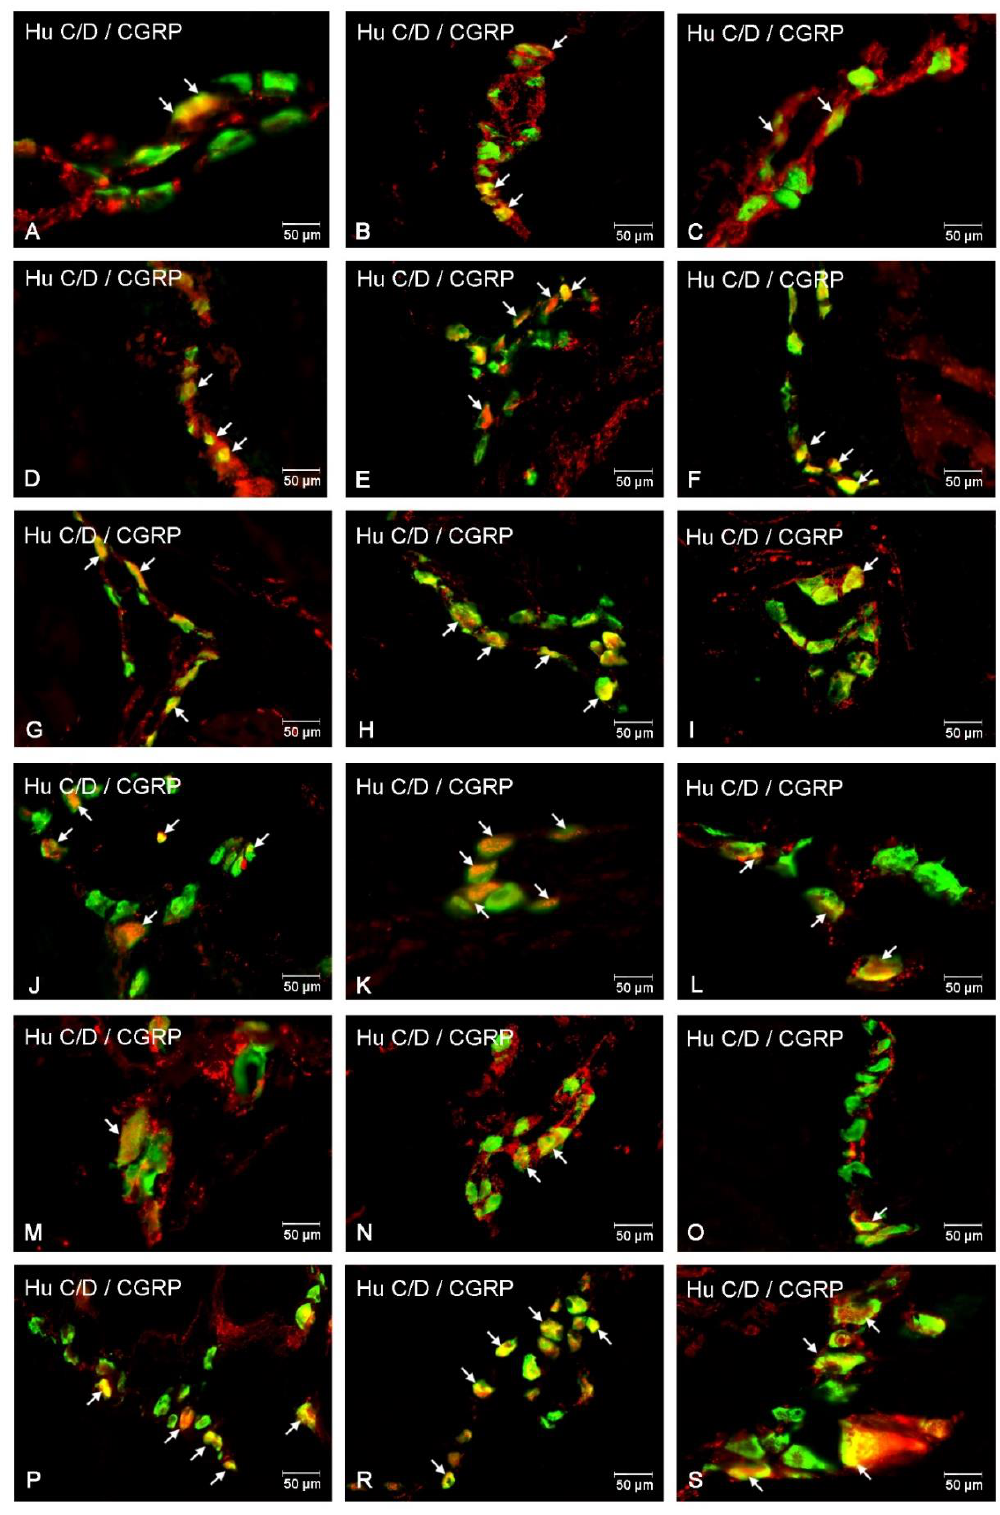
Figure 8. Immunofluorescent staining presenting CGRP immunoreactivity in cell bodies in the particular intramural plexuses in the small intestine in both control and experimental groups. All photographs have been created by the digital superimposition of two color channels; Hu C / D-positive—used here as a pan-neuronal marker (green), and CGRP-positive (red). The arrow shows perikaryon containing both examined substances. Myenteric plexus of the duodenum ( A,D ), jejunum ( B,E ), and ileum ( C,F ) under physiological condition ( A–C ) and after streptozotocin administration ( D–F ). Outer submucosal plexus of the duodenum ( G,J ), jejunum ( H,K ), and ileum ( I,L ) under physiological condition ( G-I ) and after streptozotocin administration ( J–L ). Inner submucosal plexus of the duodenum ( M,P ), jejunum ( N,R ), and ileum ( O,S ) under physiological condition ( M–O ) and after streptozotocin administration ( P–S